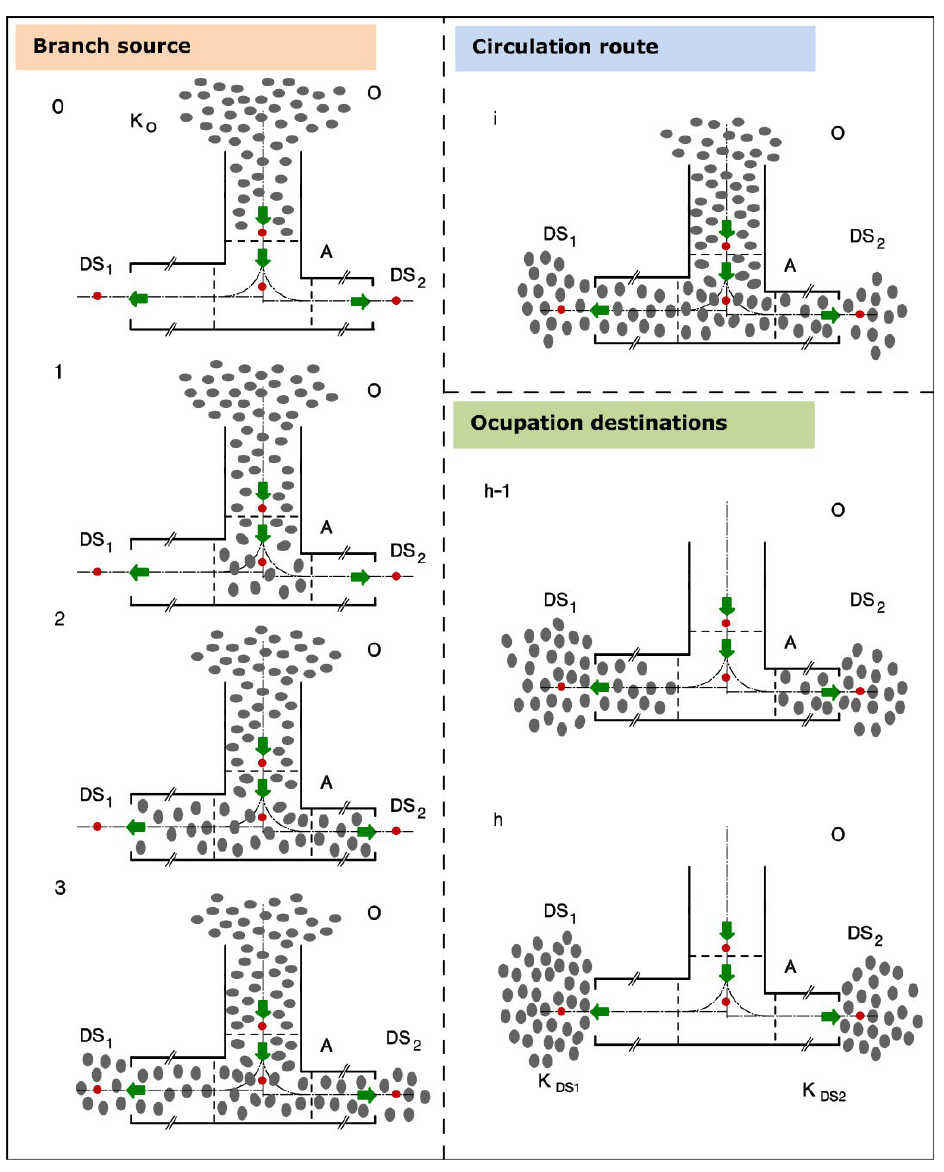
Figure 20. Analysis of the branch